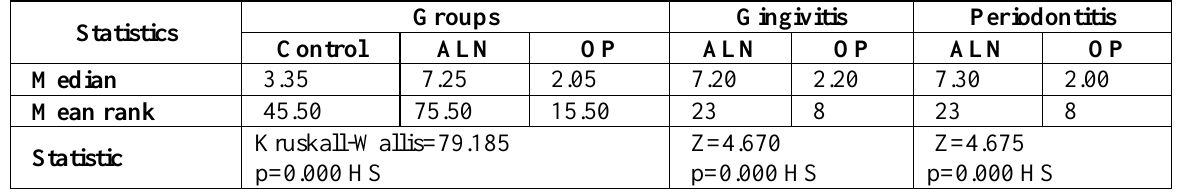
Table 1: The concentration of salivary OPG for study and control group with comparison of gingivitis and periodontitis between study groups.